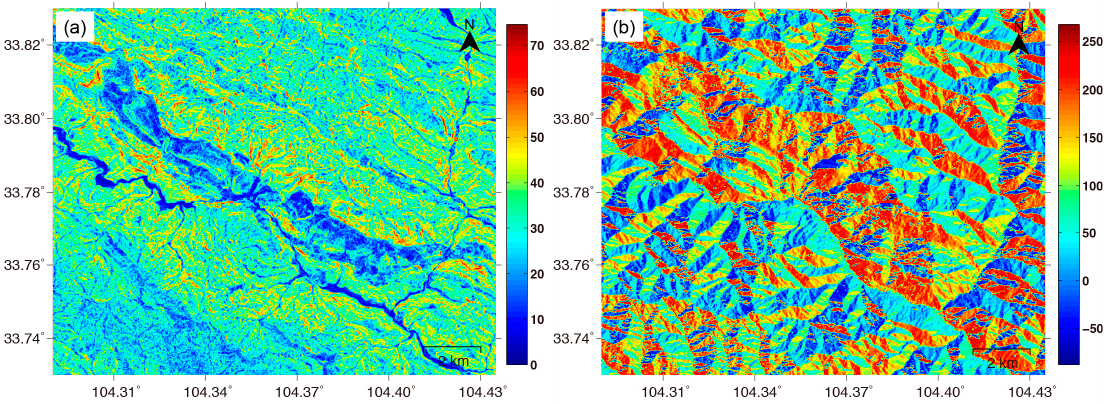
χ ( a ) and local terrain aspect angle